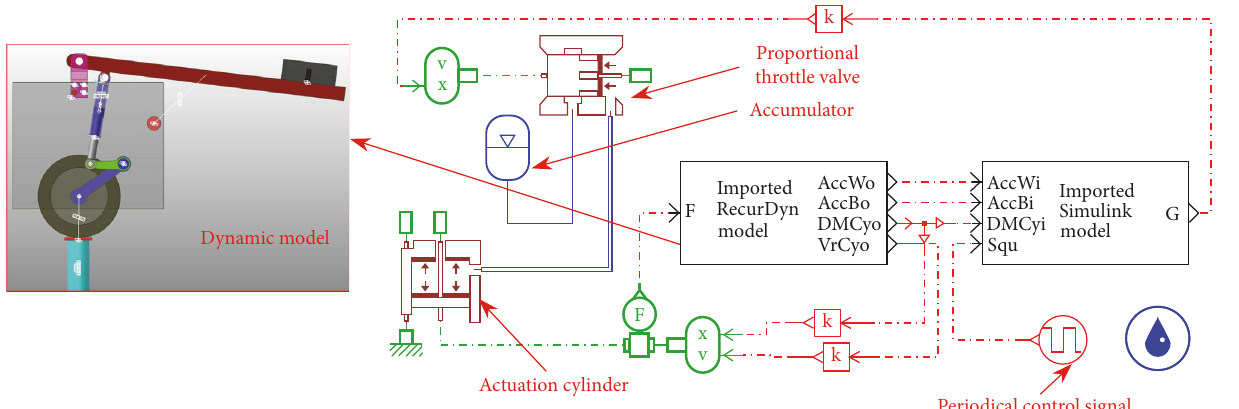
Figure 3: Cosimulation model of single-wheel